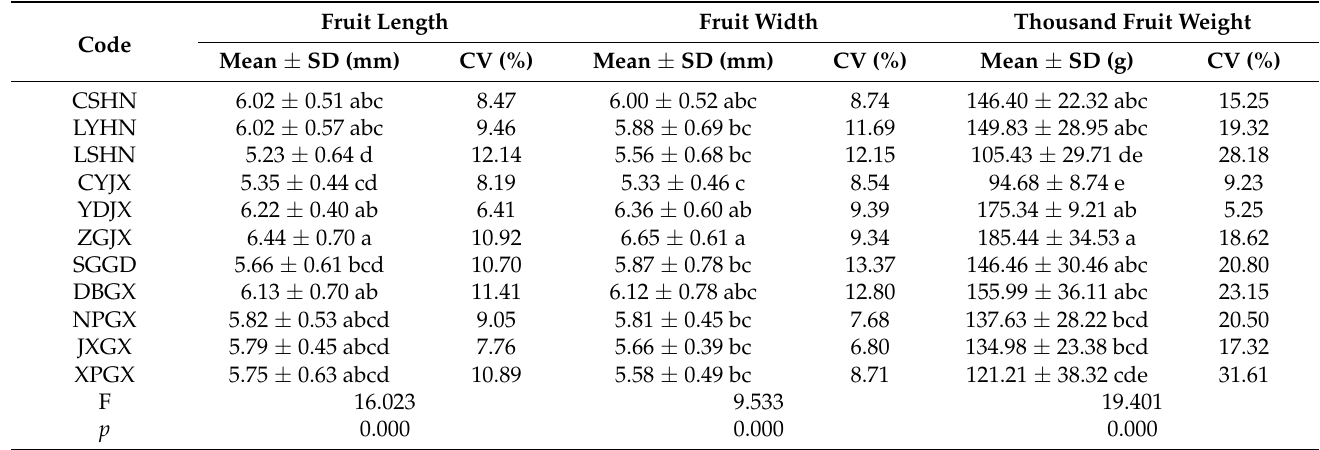
Table 2. Statistics in phenotypic trait variation of S. wilsoniana